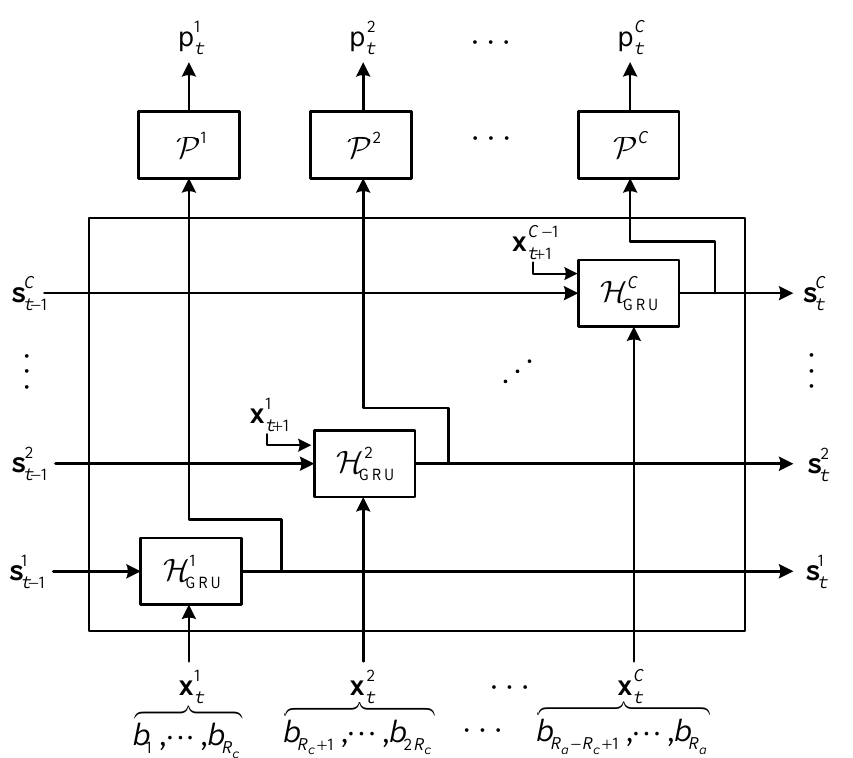
Figure 2. Structure of the proposed multi-channel recurrent